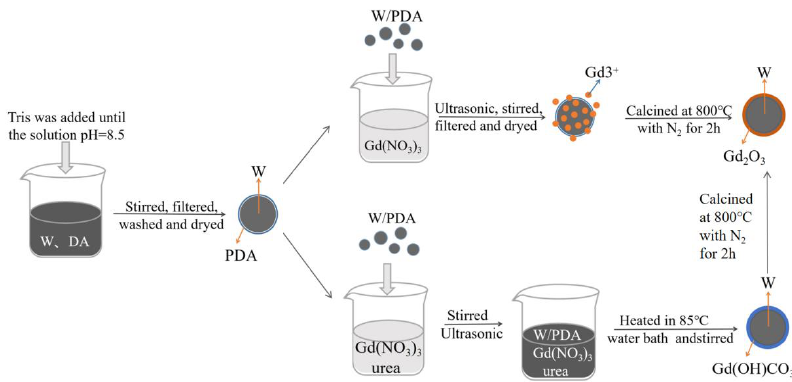
Figure 1. Schematic of the preparation of core – shell structure W/Gd 2 O 3 .